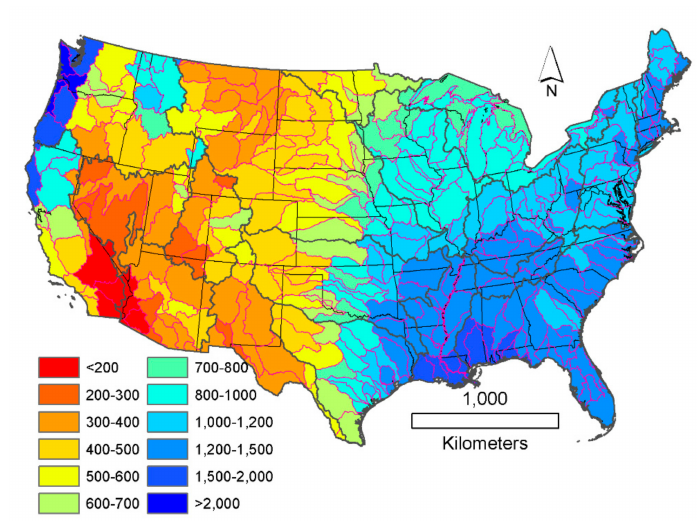
Figure 2. Spatial distribution of the mean annual (1979–2015) HUC6-averaged PRISM precipitation rates (mm yr − 1 ).